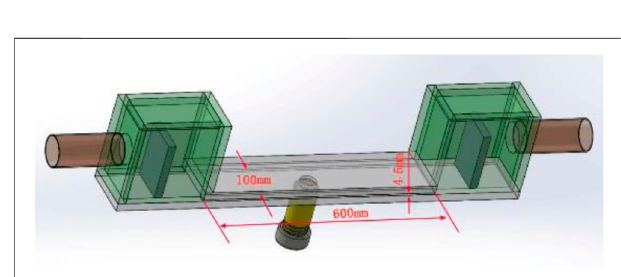
FIGURE 4 | Experimental test